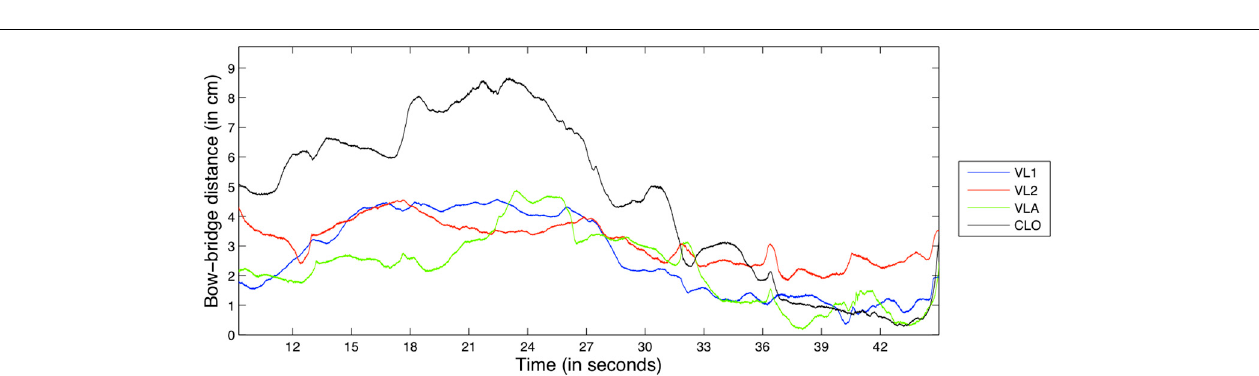
FIGURE 3 | Excerpt from the logRMS feature from exercise D1, for all instruments.